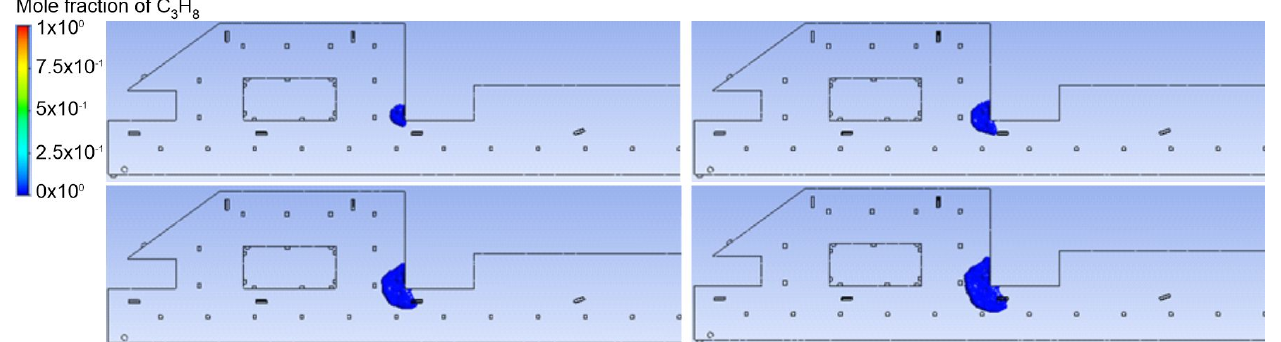
Figure 20. Upper explosive limit of LPG dispersion for B source for the following time steps 20 s, 35 s, 55 s and 70 s.